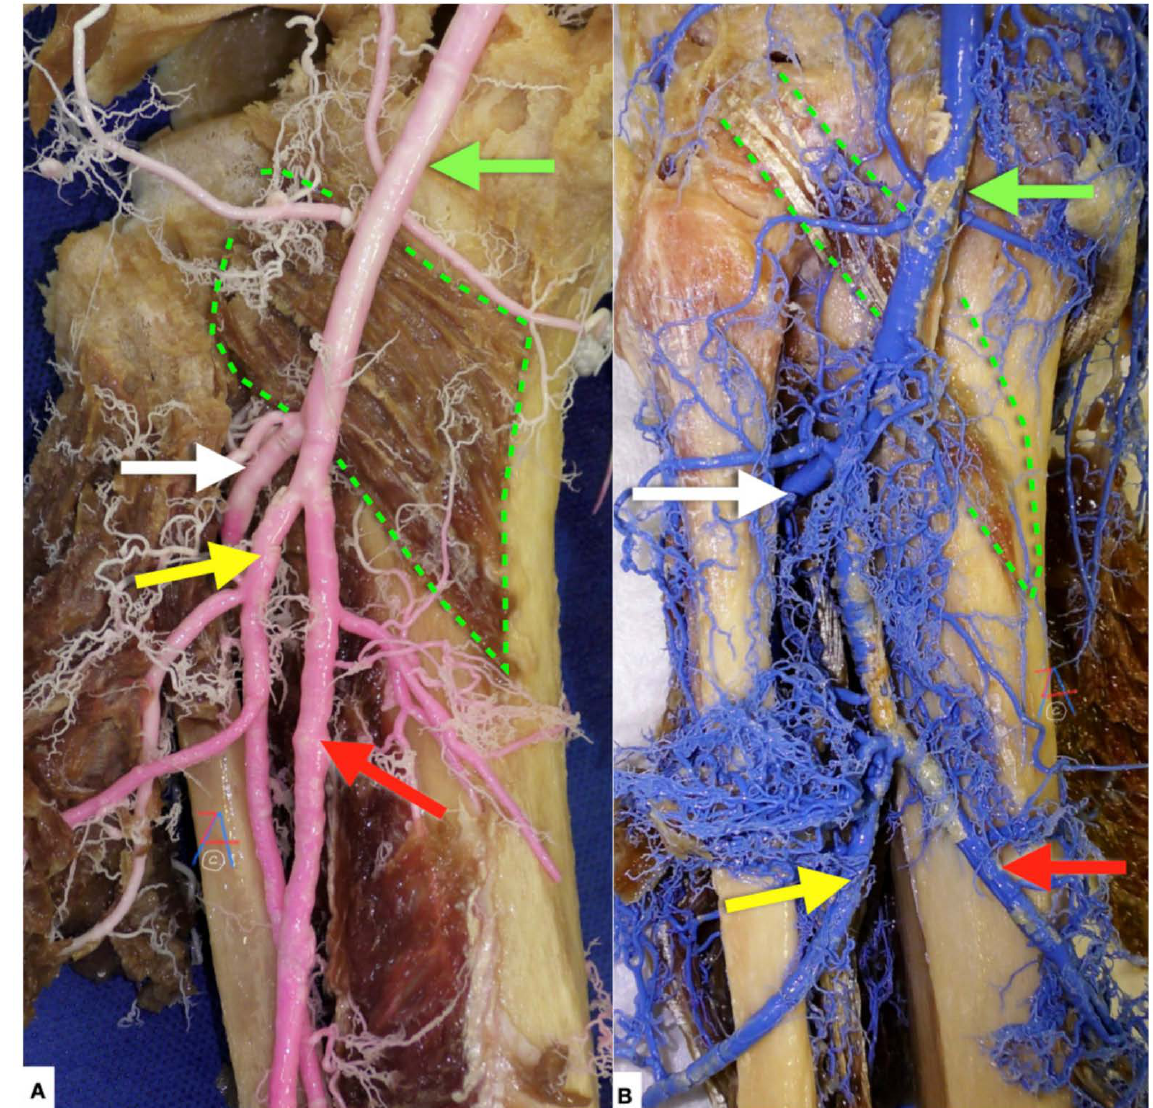
Figure 11. ( A ) Left knee, posterior view. Green arrow: popliteal artery, white arrow: anterior tibial artery, yellow arrow: peroneal artery, red arrow: posterior tibial artery, green dotted line: popliteus muscle. ( B ) Left knee, posterior view. Green arrow: popliteal artery, white arrow: anterior tibial artery, yellow arrow: peroneal artery, red arrow: posterior tibial artery, green dotted line: popliteus muscle. Both images depict the commonest configuration of popliteal artery division. The popliteal artery is divided below the knee into the anterior tibial artery and a common trunk for the posterior tibial and peroneal arteries, found in 92.6% of cases according to Tomaszweski et al. [8] and in 86.49% of cases according to Lambrecht et al.